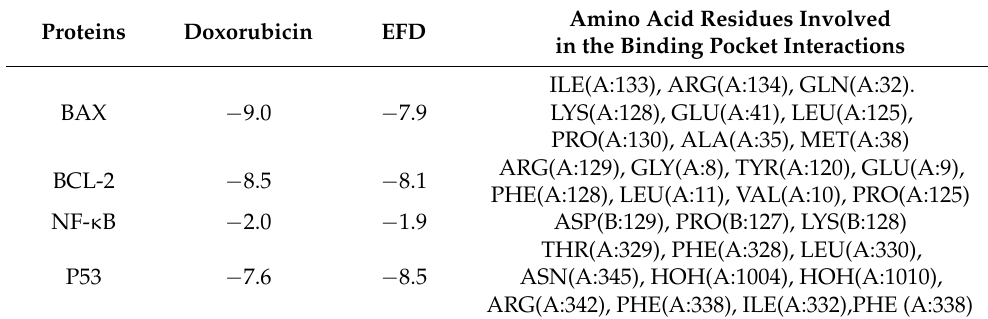
Table 1. Ligands’ binding affinity for target proteins. Residues of amino acids implicated in the interactions between the binding pocket and EFD. Amino Acid Residues Proteins Doxorubicin EFD